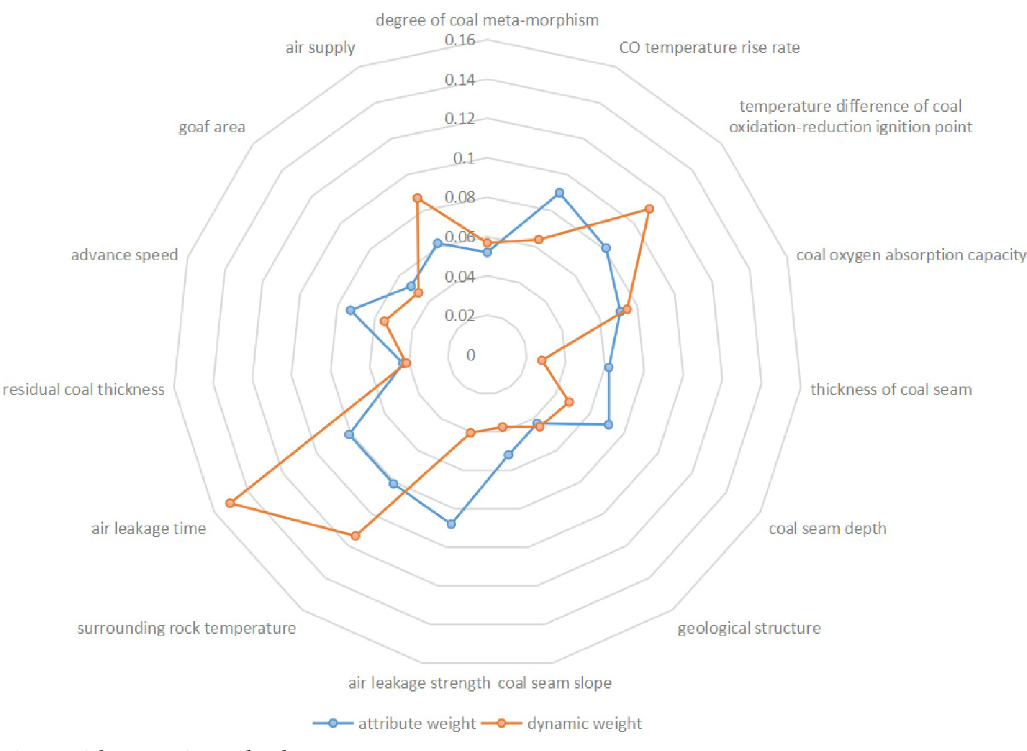
Fig 2. Weight comparison radar